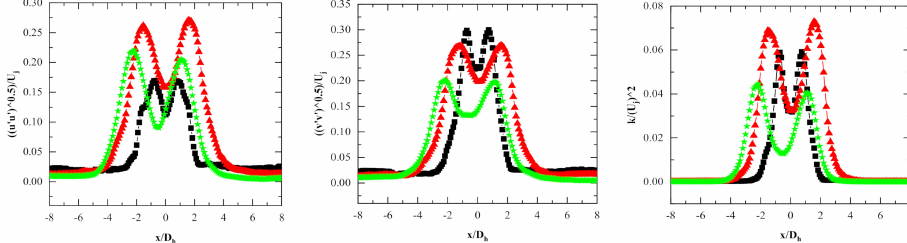
Figure10. Time-averagedvelocitycomponentsandfluctuationsalongy / D h =